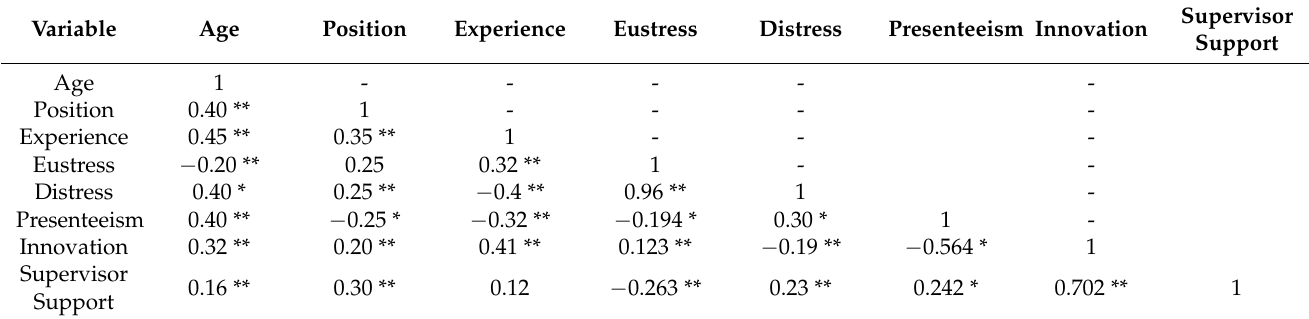
Table 2. Correlations among the studied variables.